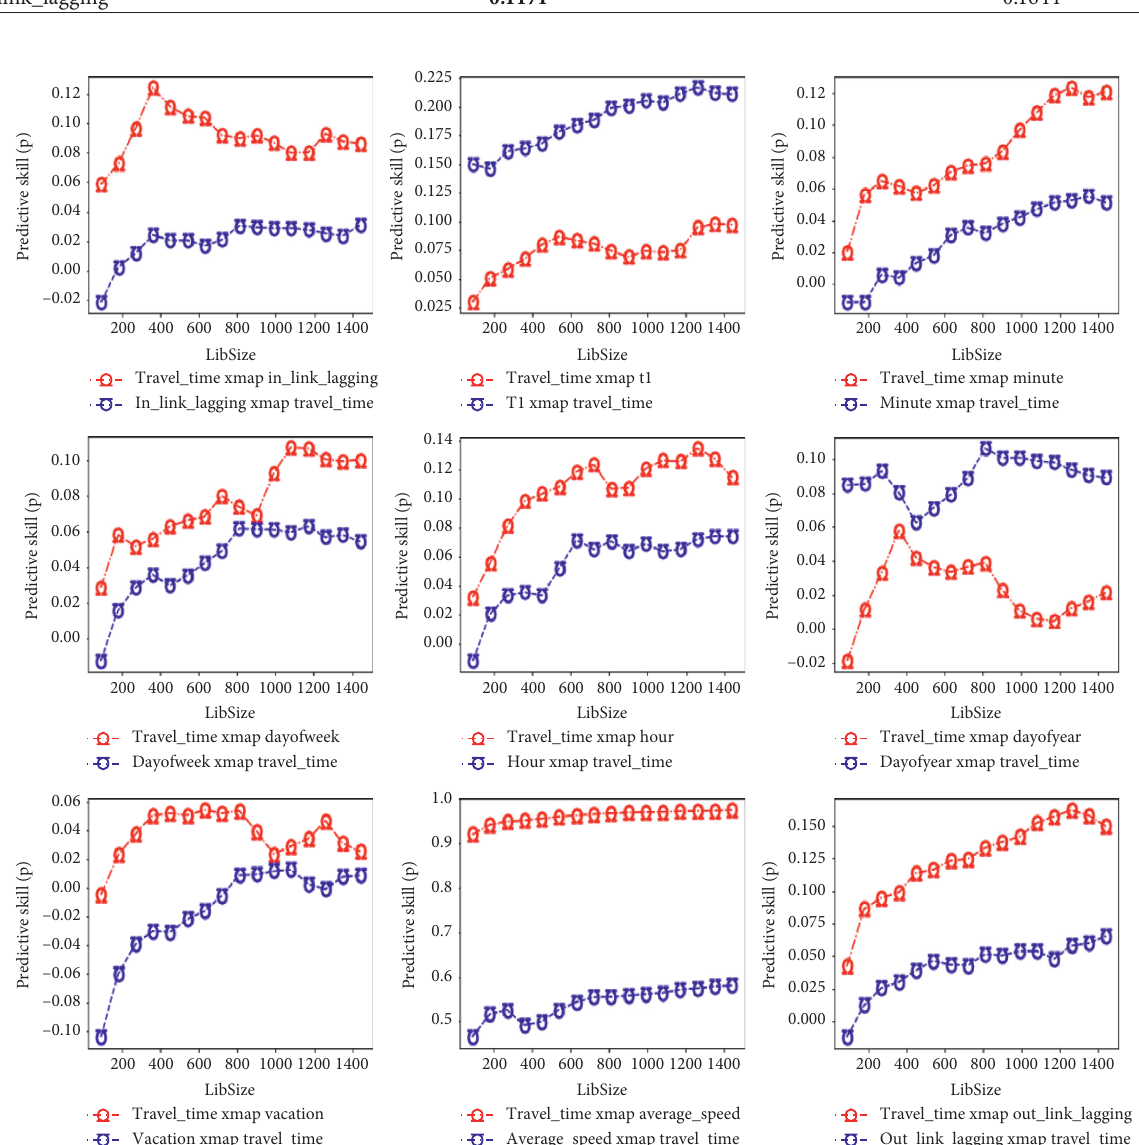
Figure 6: External driver factor CCM test for the travel time